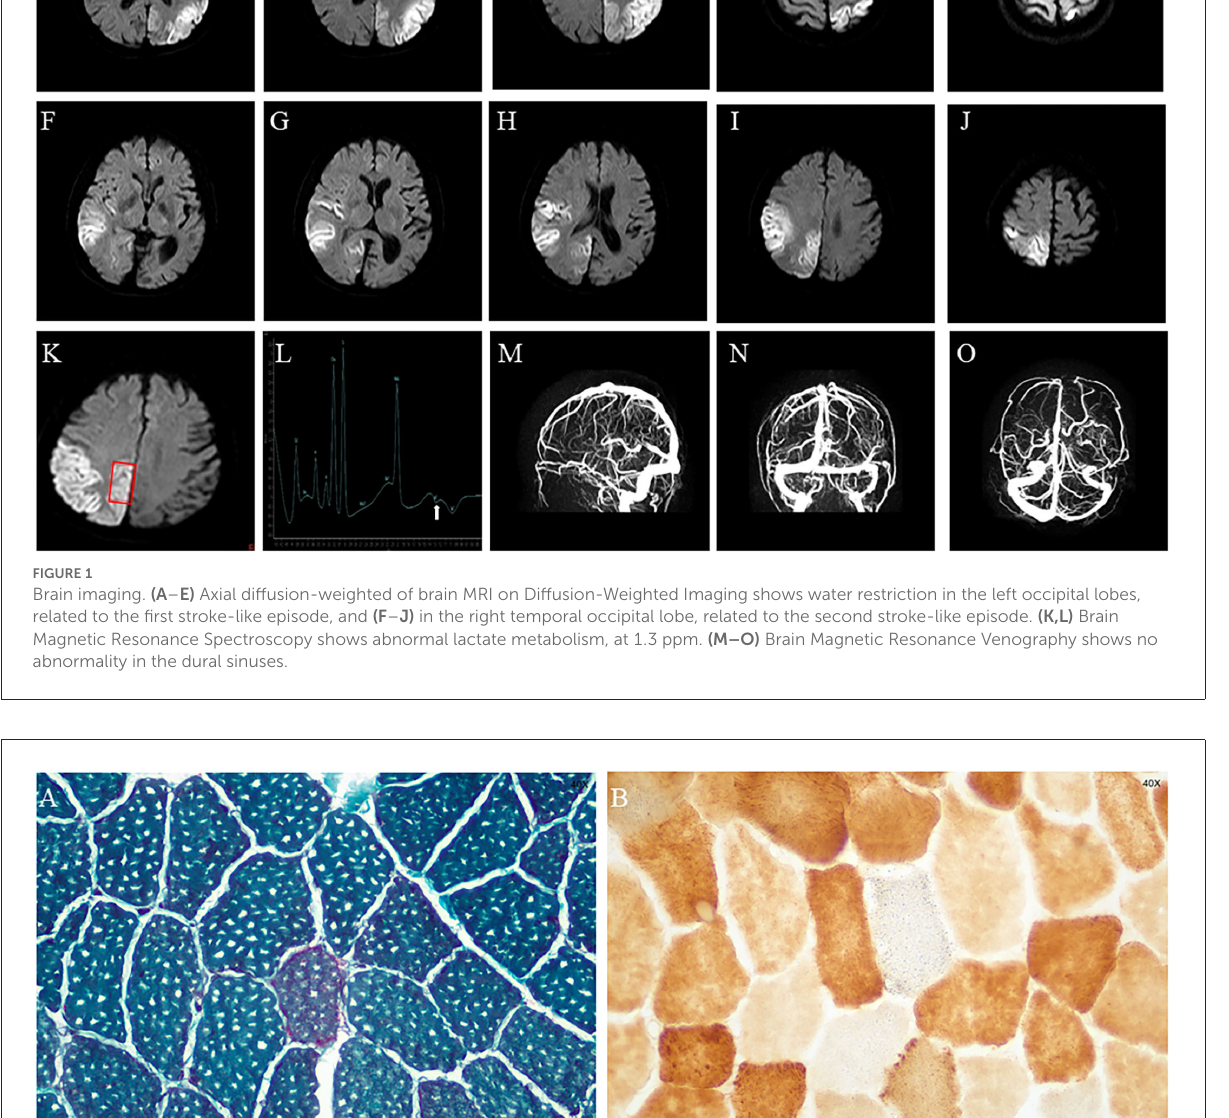
mutations were found in DNA from muscle samples, but not from blood samples. Two pathogenic mutations: TL1m.3243A > G and POLG c.3560C > T were identified in our